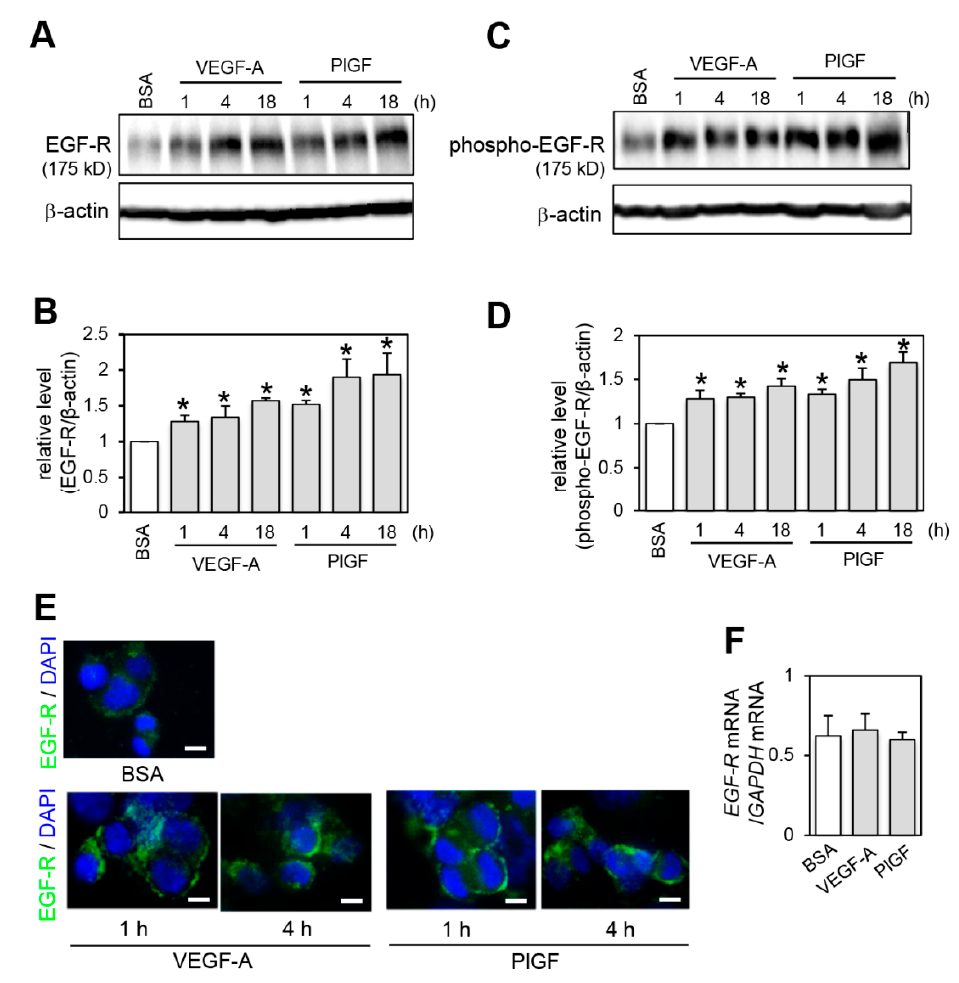
Figure 2. VEGFR-1 activation results in increased EGF-R expression levels. ( A – D ) Cells were treated with control BSA for 18 h, or with VEGF-A or PlGF for the indicated times. EGF-R ( A ) and phosphorylated EGF-R ( C ) levels were determined by immunoblot analysis. The levels of β -actin are shown as a loading control. Quantification of EGF-R levels ( B ) and phosphorylated EGF-R levels ( D ) normalized to β -actin from three independent experiments. * p < 0.01, statistically significant increase compared with the BSA-treated control. ( E ) Immunofluorescent staining with cell surface EGF-R. Cells were pre-treated with control BSA for 4 h or with VEGF-A and PlGF for the indicated times. Living cells were then incubated with an anti-EGF-R antibody conjugated with FITC for 30 min at 4 degrees and fixed. Nuclei were stained with 4 ′ ,6-diamidino-2-phenylindole (DAPI). Representative fluorescent images are shown. Scale bar = 10 μ m. ( F ) Expression levels of EGF-R mRNA were determined by RT-qPCR analysis. Values were normalized for the amount of GAPDH mRNA ( n = 5, means ± SD).